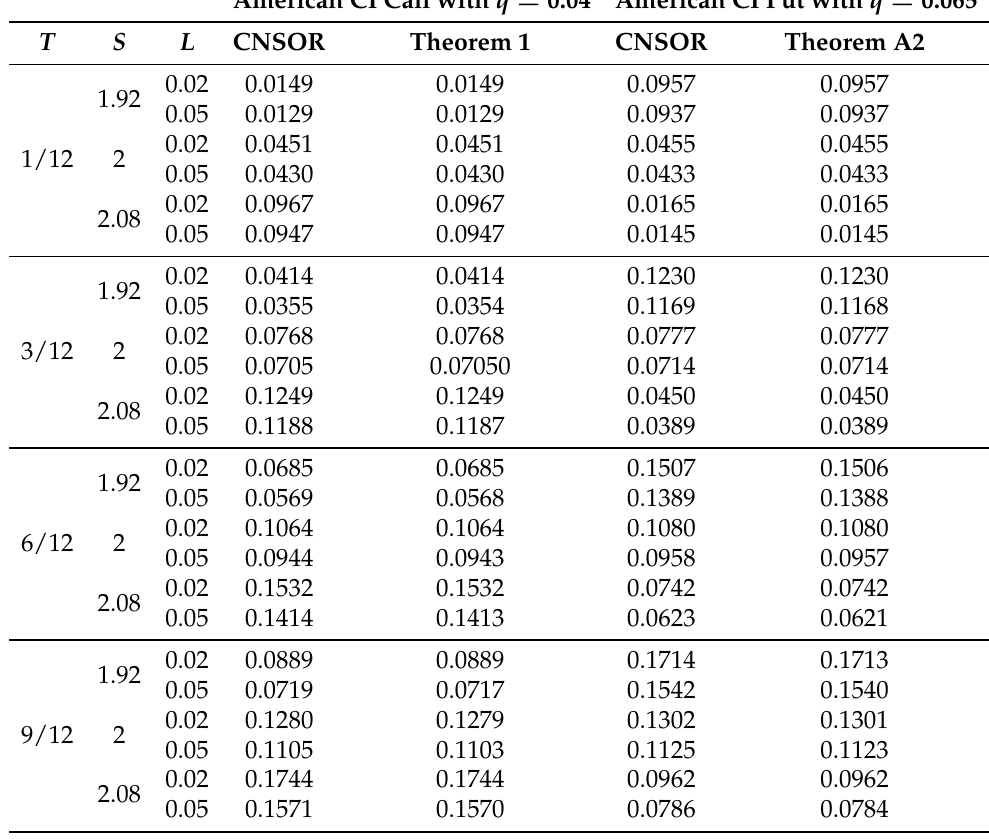
Table 3. Comparison of American CI call and put option prices using CNSOR, Theorem 1 and Theorem A2 . Parameters used: X = 2, r = 0.05, σ = 0.2. American CI Call with q = 0.04 American CI Put with q =